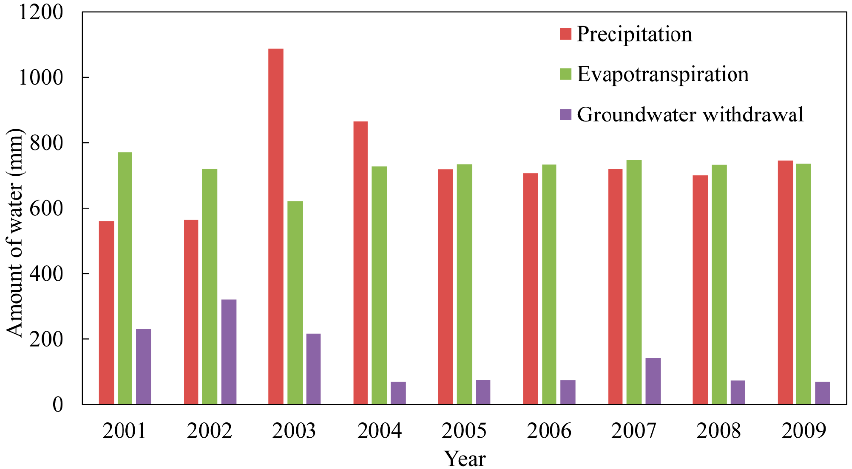
Figure 8. Annual precipitation, evapotranspiration, and groundwater withdrawal from 2001 to 2009.